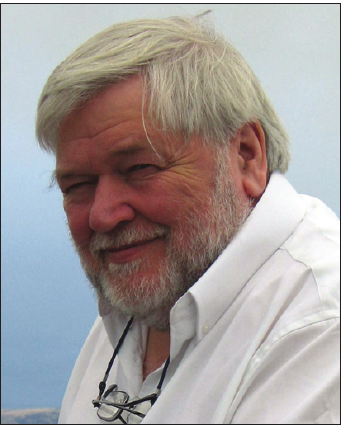
Figure 6: John Wilkins (Photo Ruth